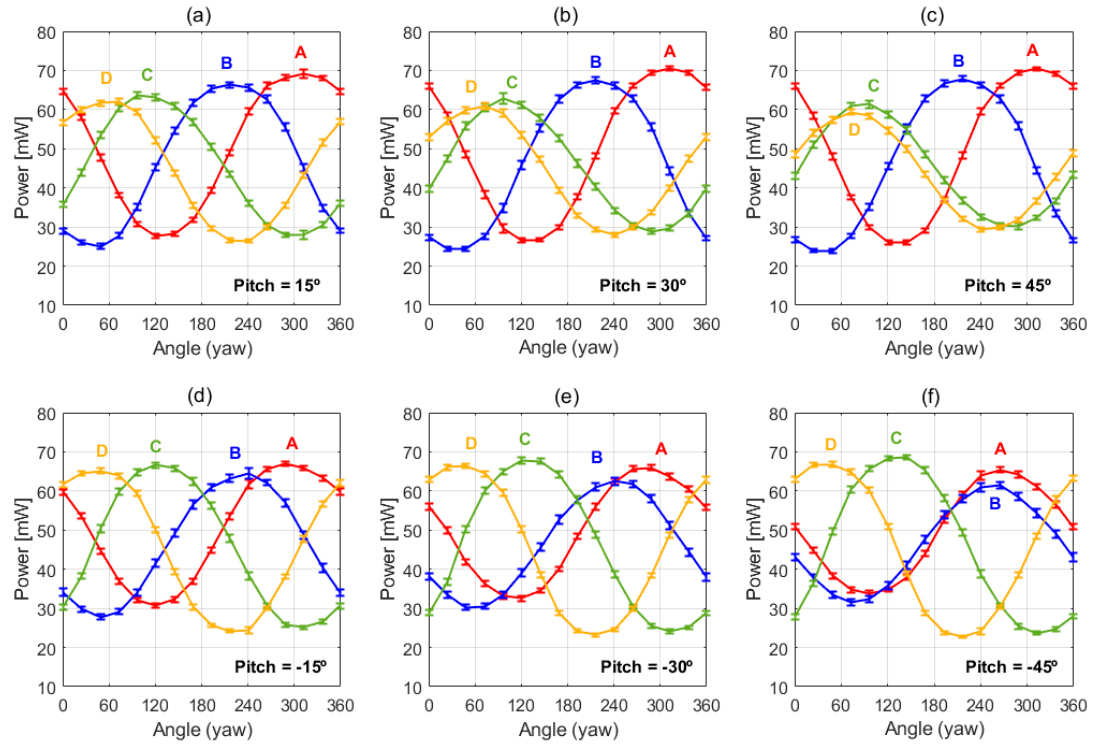
Figure 12. Power delivered to the four sector resistors of the spherical sensor for six non-zero pitch angles and complete yaw rotations, in the same conditions as the experiment reported in Figure 11. Pich angles are: ( a ) 15 °, ( b ) 30°, ( c ) 45° and ( d ) − 15°, ( e ) − 30°, ( f ) − 45°. The 1 σ error bars of the measurements are also shown. The sectors (A, B, C and D) follow the same disposition as the one shown in Figure 11 (Left).